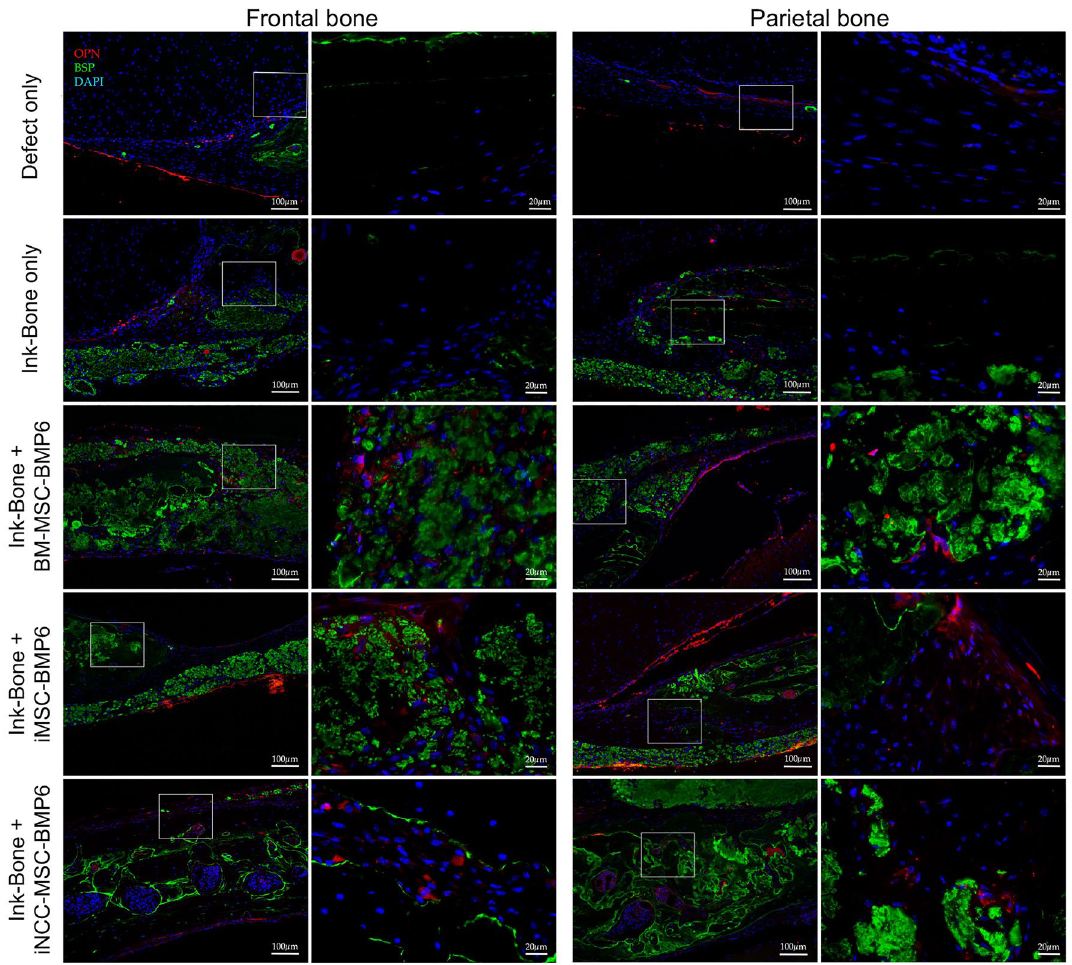
Figure 7. Immunofluorescence staining of the calvarial defect repair in a mouse model using Ink-Bone + iNCC- MPC-BMP6 and control groups. Immunofluorescence shows a DAPI, anti-human OPN (osteopontin) or human BSP (bone sialoprotein) staining. The antibody against BSP Scale bars indicate 100 µm in the left and 20 µm in magnified images in the right